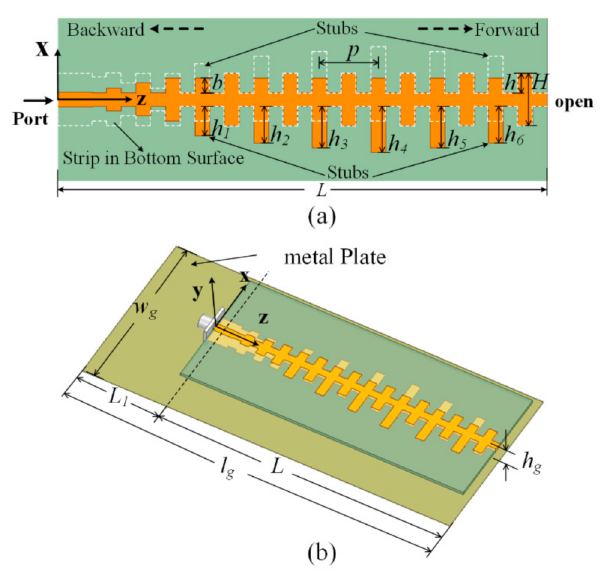
Figure 8. The profile of the proposed antenna. ( a ) top view, ( b ) full view. w g = 62 mm, l g = 130 mm, L = 100 mm, h g = 8 mm, h 1 = 6 mm, h 2 = 7.5 mm, h 3 = 8.5 mm, h 4 = 9.5 mm, h 5 = 8.5 mm, h 6 = 7.5 mm.